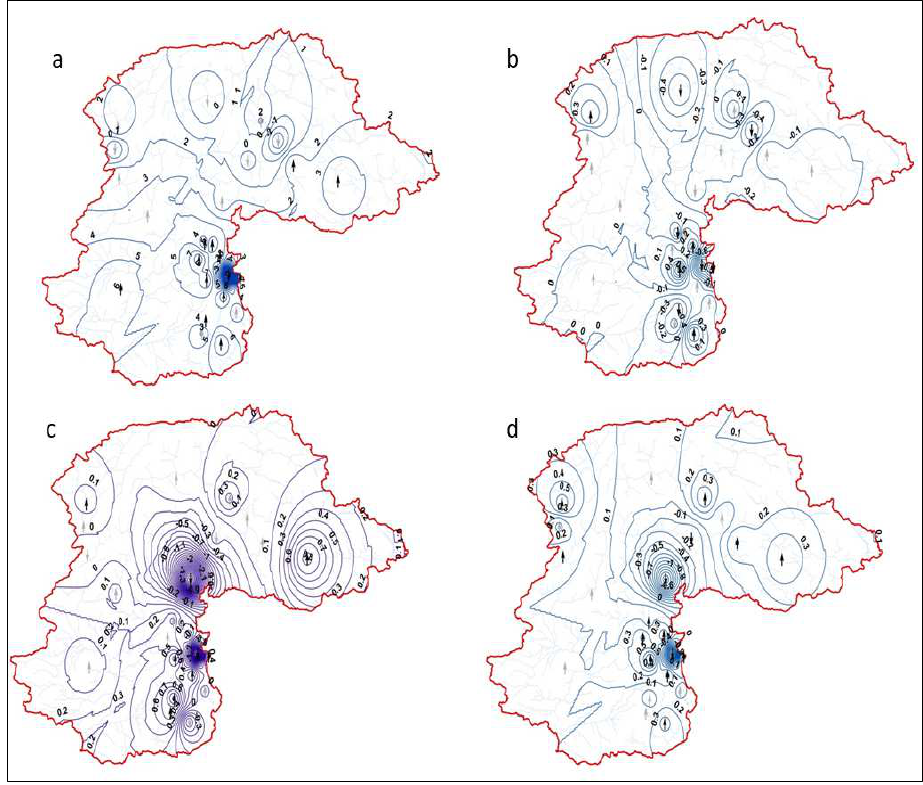
Figure 4. Change in Tmax extreme indices: ( a ) SU25, ( b ) TXx, ( c ) TXn, and ( d ) TXm. Upward/downward arrows represent positive/negative trends, respectively; bold arrows represent significant trends at α = 0.05.